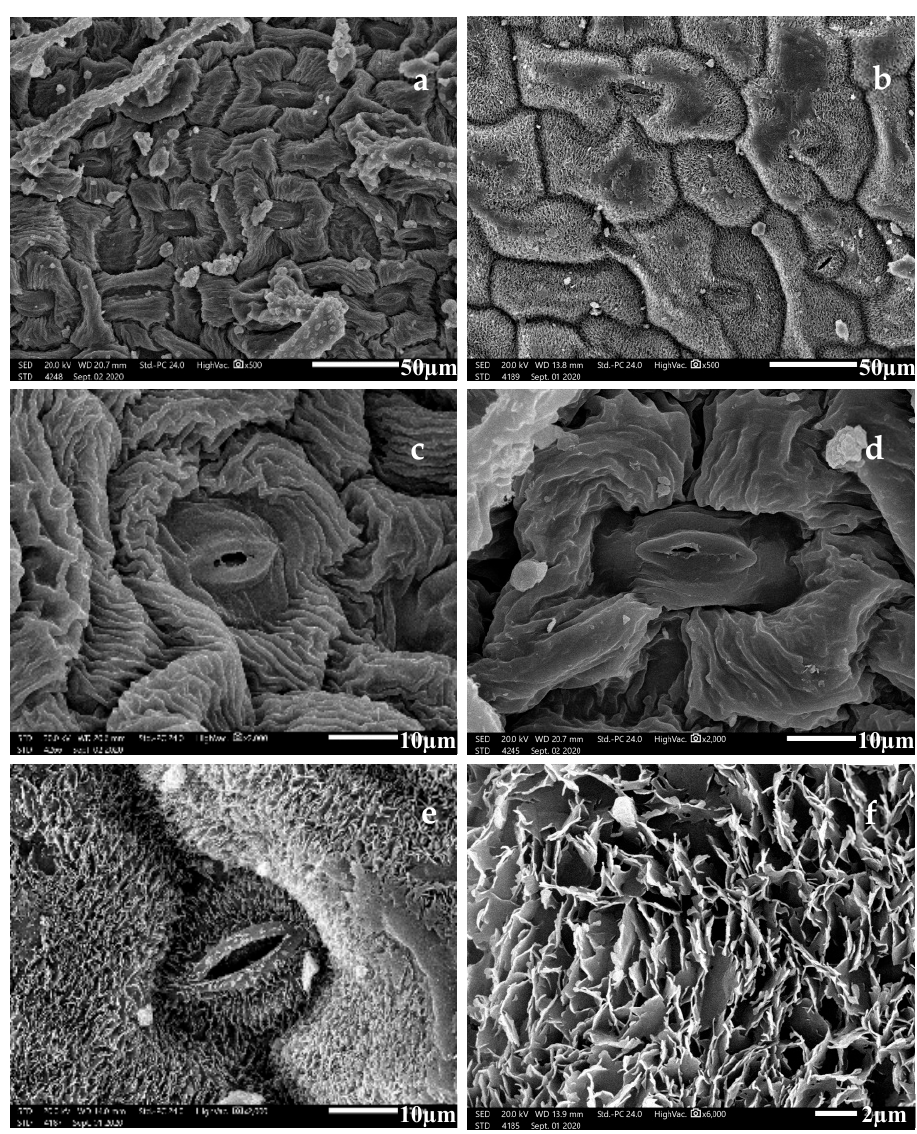
Figure 3. Scanning Electron Microscope (SEM) photomicrographs of Silene leaf surfaces. Epidermal cell shapes in ( a ) Silene leucophylla and ( b ) Silene schimperiana . Ribbing pattern of fine relief in Silene leucophylla : ( c ) densely ribbed and raised stomata, ( d ) moderately ribbed. Epicuticular platelets in Silene schimperiana : ( e ) with sunken stomata, ( f ) irregular platelets. (Abaxial leaf surface ( b , c , e ); Adaxial leaf surface ( a , d , f ). The anticlinal walls (AW) were sunken, irregularly channeled and curved in S.